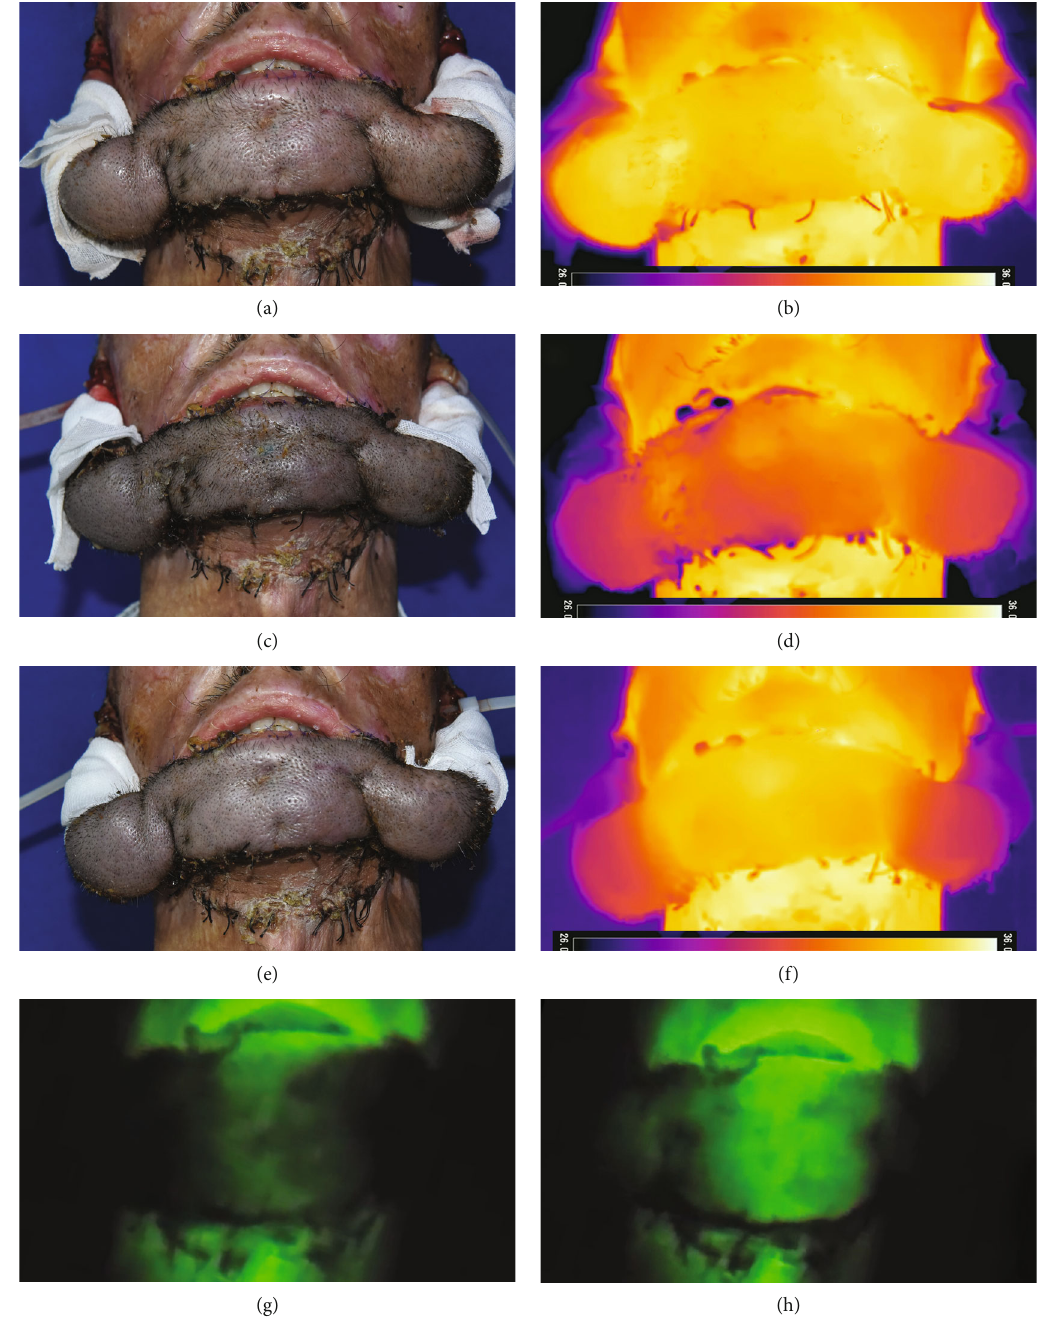
Figure 4: A typical process of temperature change (temperature threshold: 26-36 ° C). (a and b) The baseline appearance and temperature before the fi rst clamping. (c and d) After the fi rst clamping, the temperature dropped signi fi cantly and the color of the fl ap turned darker, although the color change was not easily recognized from the photo due to the color of the scalp. (e and f) After training for 4 days, the subjective evaluation was satis fi ed and the temperature of the main body showed narrowed decline, while the temperature of the tissue bridge still dropped signi fi cantly. (g and h) ICG angiography: (above) the perfusion originated from the recipient site and (down) the whole main body of the fl ap was perfused well and the perfusion to the tissue bridge was insu ffi